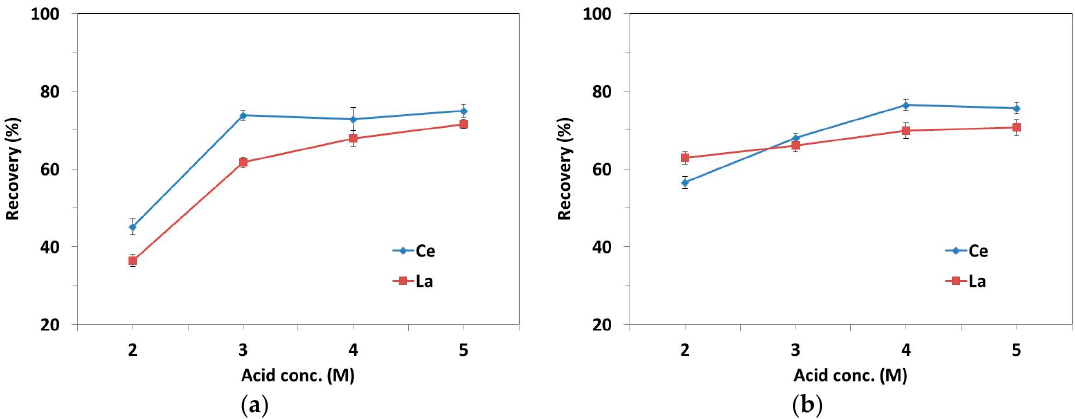
Figure 5. Effect of HCl concentration on leaching of rare earth elements (REEs) from polishing waste samples (T: 75 °C, t: 4 h, L/S: 10). The recovery of La and Ce was lower in ( a ) sample A compared to ( b ) sample B at low acid concentrations. However, the maximum recoveries of La and Ce were similar for both samples at high acid concentrations, which were about 70%. Sample A is from plate glass polishing and sample B is from mirror polishing.